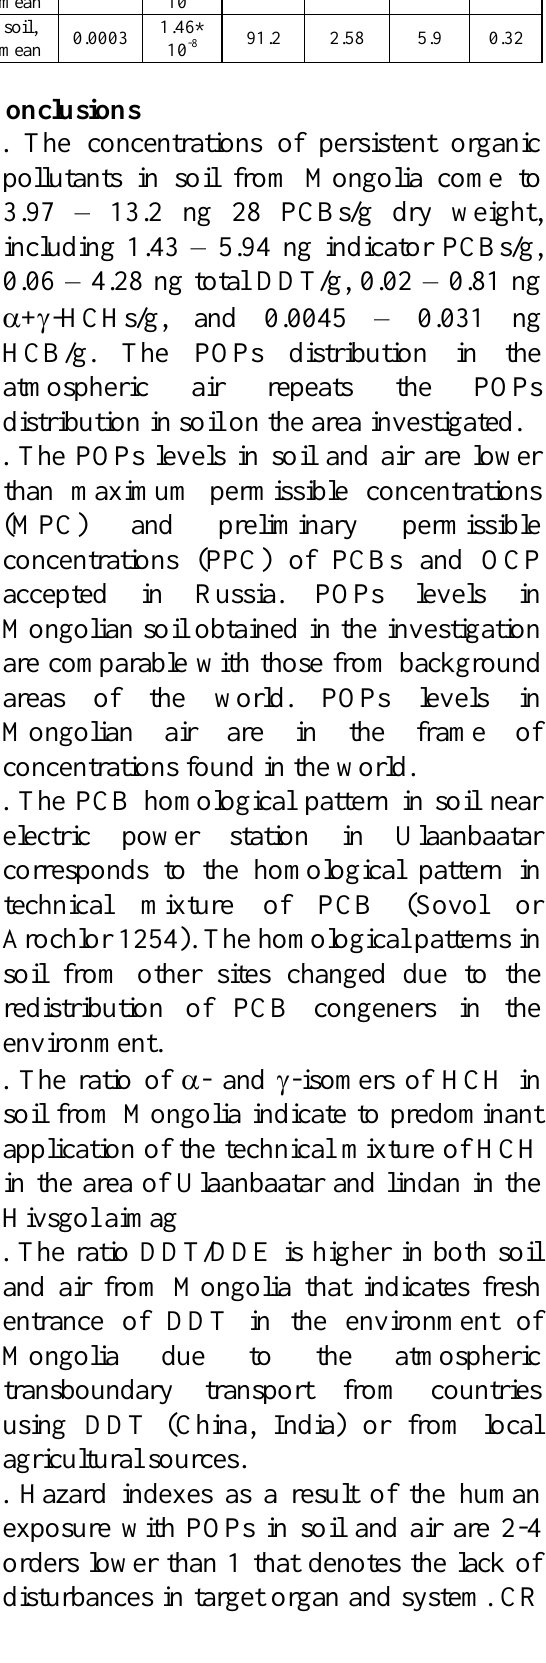
Table 3. The hazard indexes (HI), carcinogenic risk (CR) and the contribution of individual groups of POPs in total CR under human exposure as a result o f